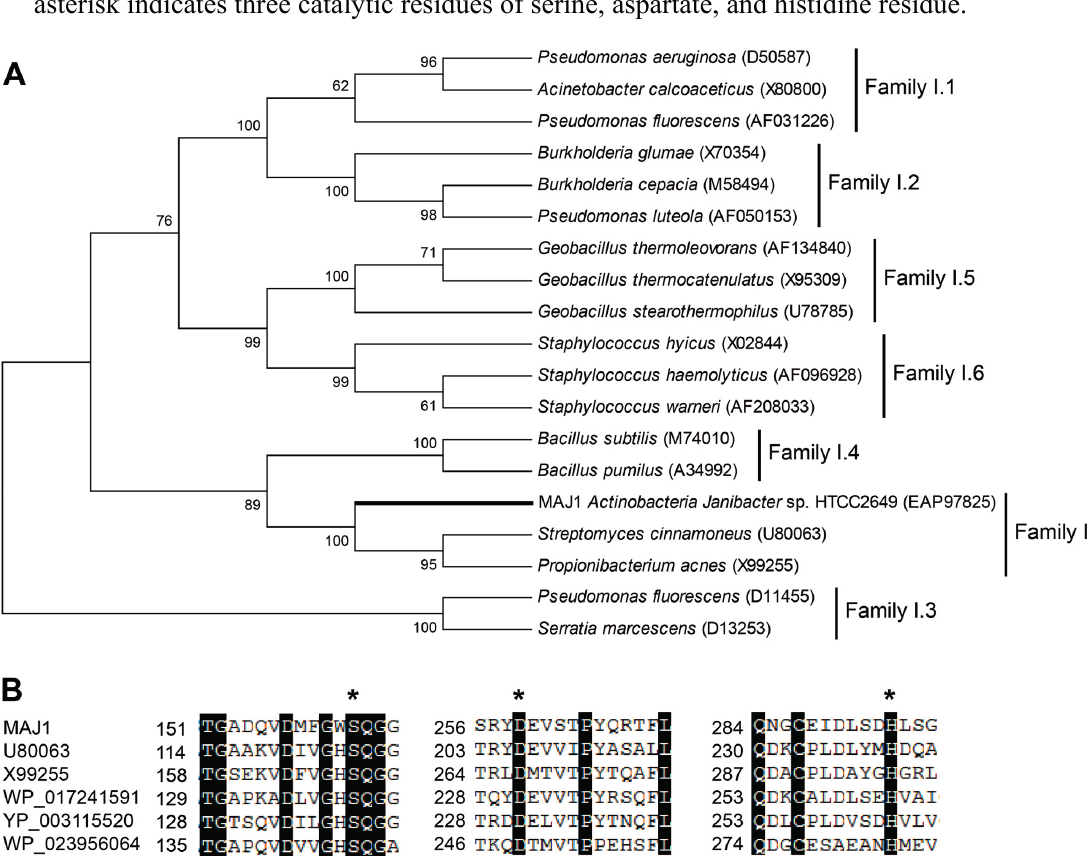
Figure 1. Gene features of MAJ. ( A ) Phylogenetic tree of the lipase family I. The tree was constructed using the MEGA 6.0 program with the neighbor-joining algorithm. Bar: 0.2 substitutions per amino acid site; and ( B ) Multiple sequence alignment of MAJ1 and other related proteins. U80063: lipase from Streptomyces cinnamoneus ; X99255: lipase from Propionibacterium acnes ; WP_017241591: lipase 2 from Streptomyces sp.; YP_003115520: lipase 2 from Catenulispora acidiphila ; WP_023956064: lipase from Williamsia sp. D3. The asterisk indicates three catalytic residues of serine, aspartate, and histidine residue.